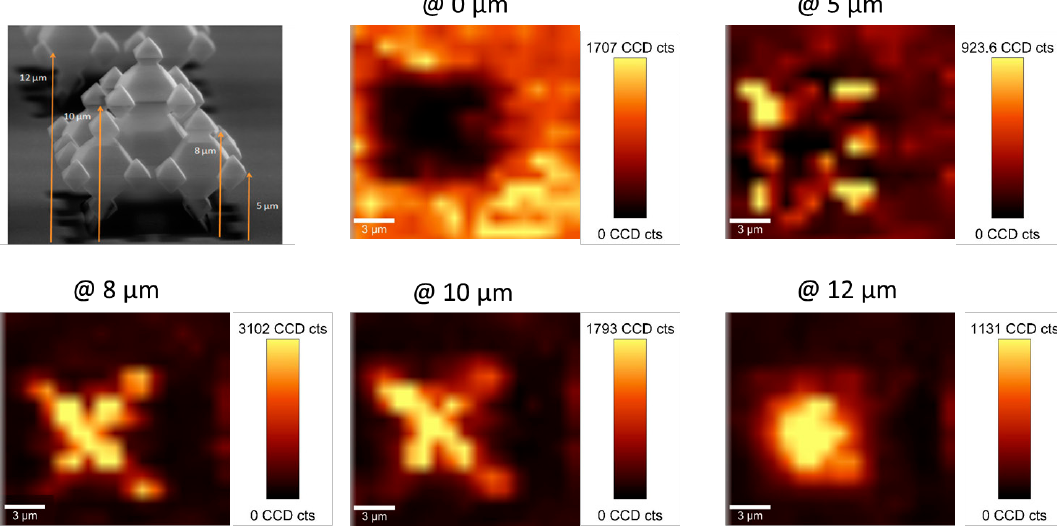
Figure 9. SERS Active 3G_Ag_AuNP substrates: SEM image and Raman signal mapping across a 20 × 20 μm at different heights (z-position) from the bottom: 0 μm (bottom surface); 5 μm; 8 μm; 10 μm; 12 μm. Conditions: 1 mW, 1 s. Recreation of the bright areas in a cross section view of the substrate.